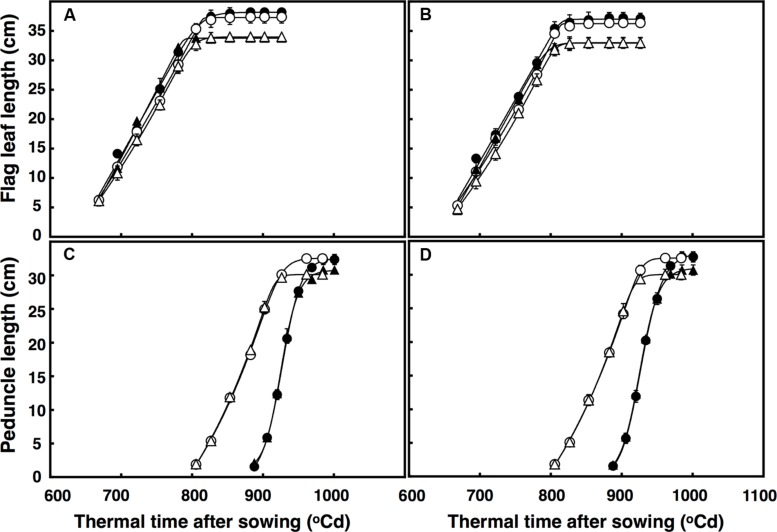
Length of the flag leaf (A,B) and peduncle (C,D) in (A) free-tillering and (B) restricted-tillering lines. Black triangles = ACO2 + HT; white triangles = ACO2 + AT; black circles = ECO2 + HT; and white circles = ECO2 + AT. Each point is mean ± SEM of 10 replicates.